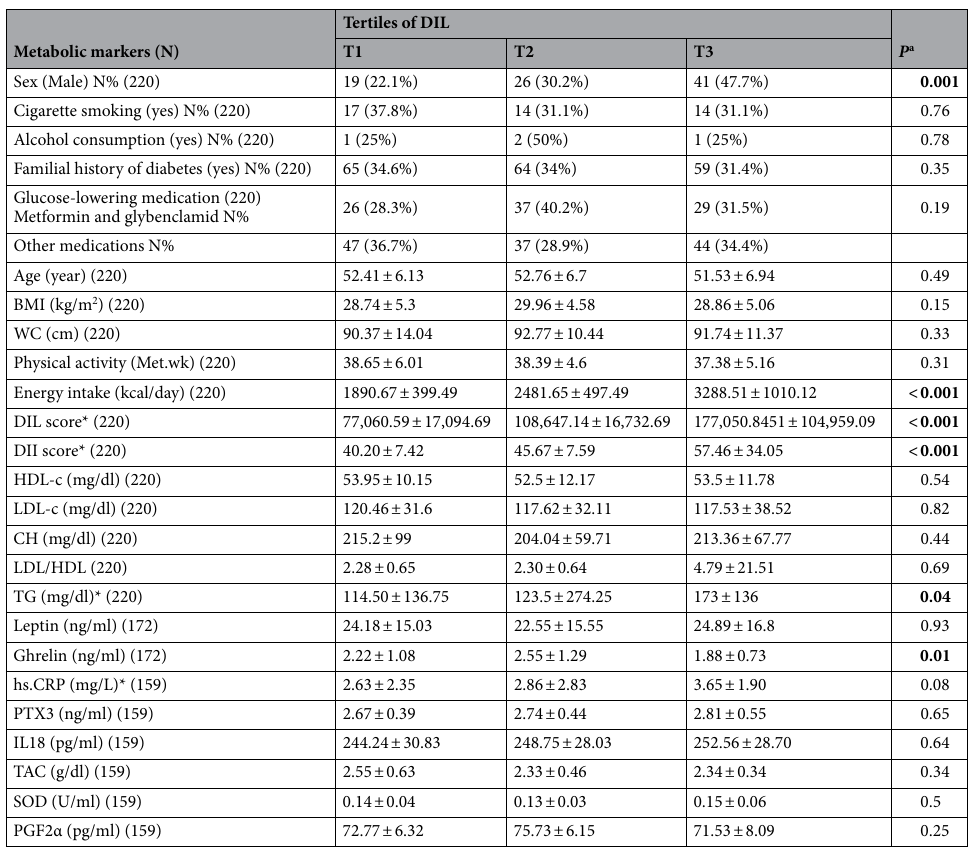
Table 2. The association between baseline characteristic and metabolic markers with dietary insulin load (DIL). Data are presented as mean ± standard deviation (SD) or percent or Median ± IQR* (TG, hs.CRP, DIL and DII). DIL: dietary insulin load; DII: dietary insulin index; BMI: body mass index; HDL-c high density lipoprotein cholesterol; LDL-c: low density lipoprotein cholesterol; CH: cholesterol; TG: triglyceride; CRP: C-reactive protein; PTX3: Pentraxin 3; IL18: interleukin 18; TAC: total antioxidant capacity; SOD: superoxide dismutase; PGF2α: prostaglandinF2α. a Obtained from ANOVA or Chi-square or Kruskal–Wallis test where appropriate. Bold values denote statistical significance at the p < 0.05